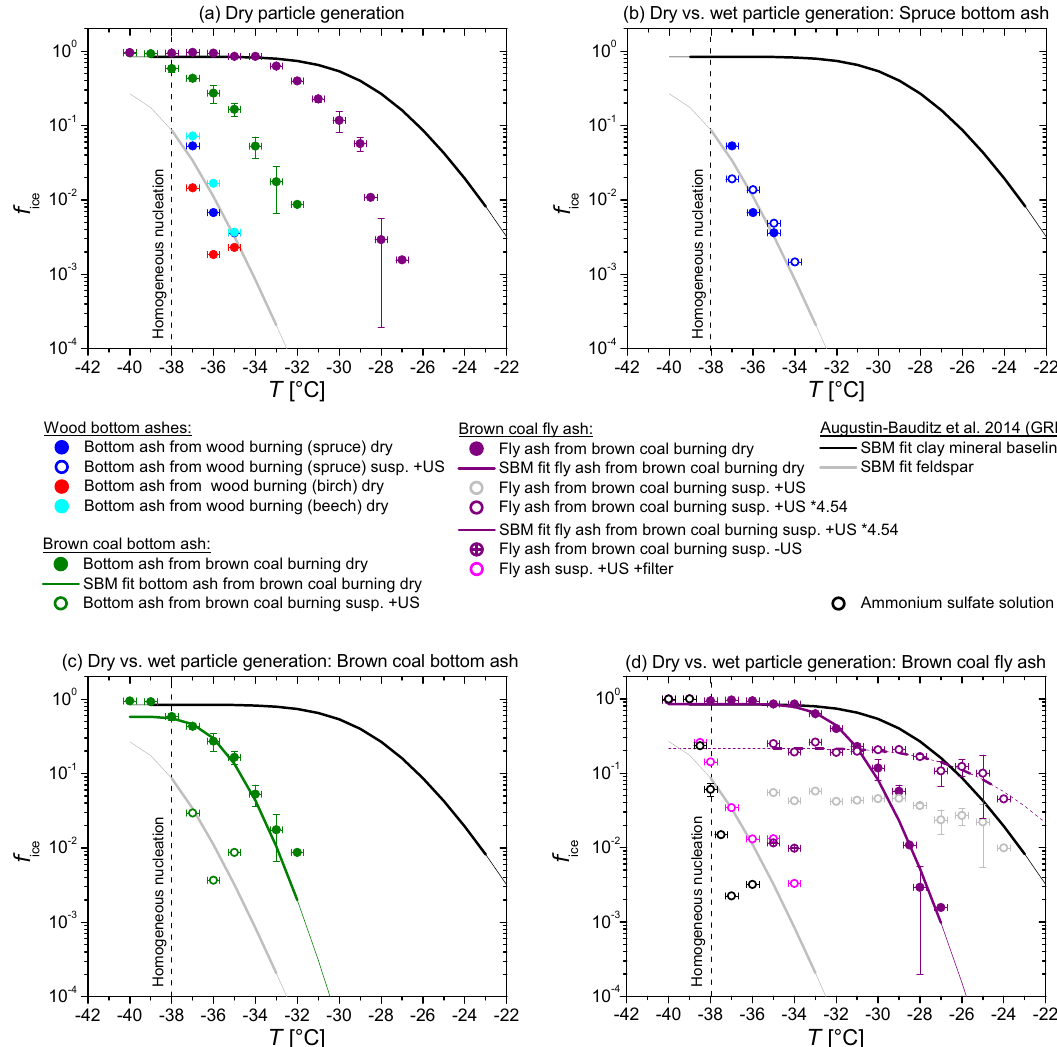
Figure 4. Ice fraction f ice as a function of temperature T for ash particles from dry (full circles) and wet generation (open circles, b , c , d ) with D p,el = 300nm. Error bars represent the LACIS temperature error of 0.3K and the f ice standard deviation of three or more measurements, respectively. A scaling factor of 4.54 was applied to the fly ash suspension measurements to account for the occurrence of crystals during wet particle generation. The solid and dashed lines represent the SBM fits to selected samples from this work and to data published in Augustin- Bauditz et al. (2014), all for D p,el = 300nm. Parameters for the SBM fits are given in Table 4. The feldspar sample from Augustin-Bauditz et al. (2014) is composed of 76% microcline (K-feldspar) and 24% albite (Na-feldspar). The clay mineral baseline corresponds to different kinds of mineral dust which featured a similar immersion freezing behavior after coating with sulfuric acid. The homogeneous region is determined by investigating the immersion freezing behavior of highly diluted ammonium sulfate droplets (black open circles, d